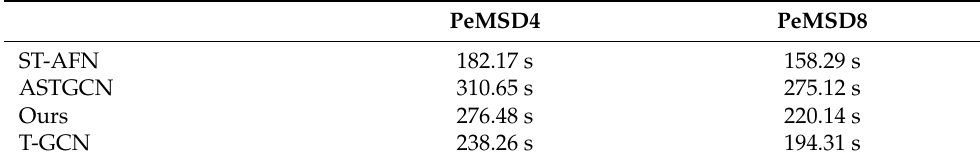
Table 5. Training cost